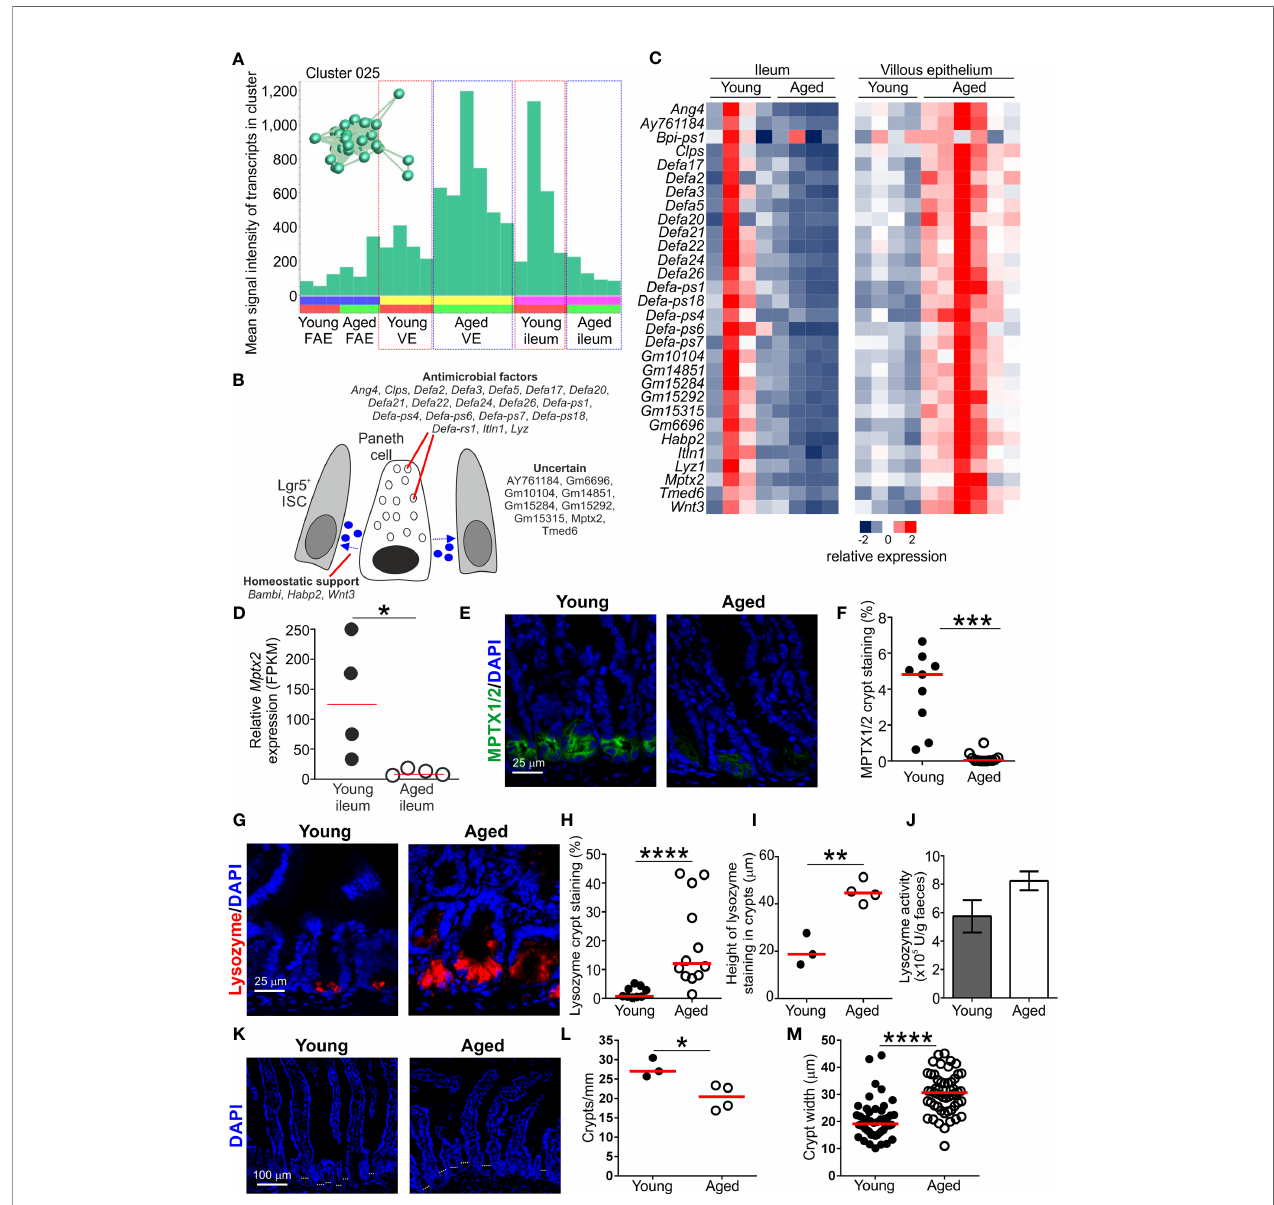
FIGURE 5 | Effect of aging on Paneth cell-related gene expression in the aged intestine. (A) Mean expression pro fi le (mean FPKM) of the genes in Cluster 025 across the 24 data sets. Inset shows the grouping of nodes in this cluster in the network graph shown in Figure 2B . (B) Cartoon describing the putative function in Paneth cells of the genes represented in Cluster 025. (C) Heat map shows the relative expression of the Paneth cell-related genes in Cluster 025 in the ileum and villous epithelium mRNA-data sets from young and aged mice. (D) Relative expression level (FPKM) of Mptx2 in individual ileum mRNA-seq data sets from young and aged mice. Horizontal bar, median. Statistical difference determined by t test. (E) Comparison of MPTX1/2 immunostaining (green) in Paneth cells in the crypts of young and aged mice. Sections counterstained with DAPI to detect cell nuclei, blue. (F) Reduced abundance of MPTX1/2+ immunostaining in the crypts of aged mice. N=9-12 images/group. Horizontal bar, median. Statistical differences determined by Mann-Whitney U test. (G) Lysozyme+ immunostaining (red) in Paneth cells in the crypts of young and aged mice. Sections counterstained with DAPI to detect cell nuclei, blue. (H) Increased abundance of lysozyme+ immunostaining in the crypts of aged mice. N=9-12 images/group. Horizontal bar, median. Statistical differences determined by Mann-Whitney U test. (I) Comparison of the magnitude of the height of the lysozyme+ immunostaining in the crypts of young and aged mice. Data represent the mean of 10-16 crypts/mouse across 3 images/mouse. Horizontal bar, median. Statistical differences determined by t test. (J) Equivalent levels of lysozyme activity in feces from young and aged mice. N=5 mice/group. Statistical differences determined by t test. (K) Representative sections of small intestines from young and aged mice. Sections stained with DAPI to detect cell nuclei, blue. Dotted lines highlight approximate crypt width. (L) Reduced abundance of crypts in the small intestines of aged mice. Data represent the mean number of crypts/mm for each mouse from images containing 4-7 mm intestine. Horizontal bar, median. Statistical differences determined by t test. (M) Increased crypt width in the small intestines of aged mice. N=48-53 crypts/group. Horizontal bar, median. Statistical differences determined by t test. *P < 0.05; **P < 0.01; ***P < 0.001; ****P <